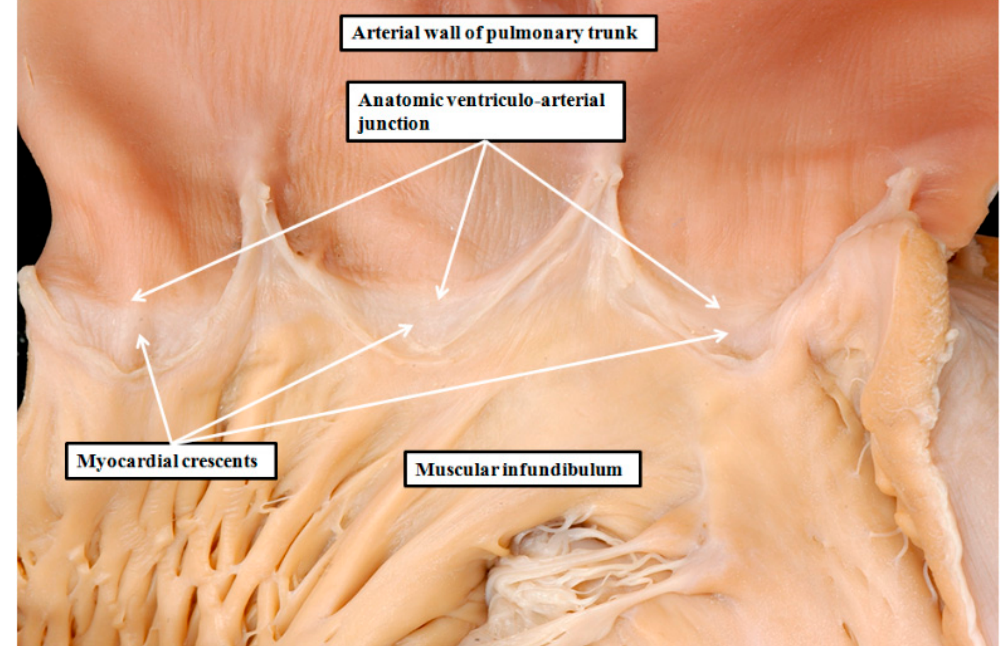
Figure 3. The image shows the right ventriculo-arterial junction of the normal heart. The heart has been opened by making a cut through the parietal component of the junction. The leaflets of the pulmonary valve have been removed to reveal their semilunar lines of attachment. This makes it possible also to recognize the circular anatomic ventriculo-arterial junction formed at the boundary between the muscular right ventricular infundibulum and the arterial wall of the pulmonary trunk. Because the hingelines of all three leaflets cross the anatomic ventriculo-arterial junction, there are crescents of infundibular myocardium incorporated at the bases of each of the pulmonary valvar sinuses. It is these myocardial components that are ablated when abolishing right ventricular outflow tract tachycardias from the pulmonary